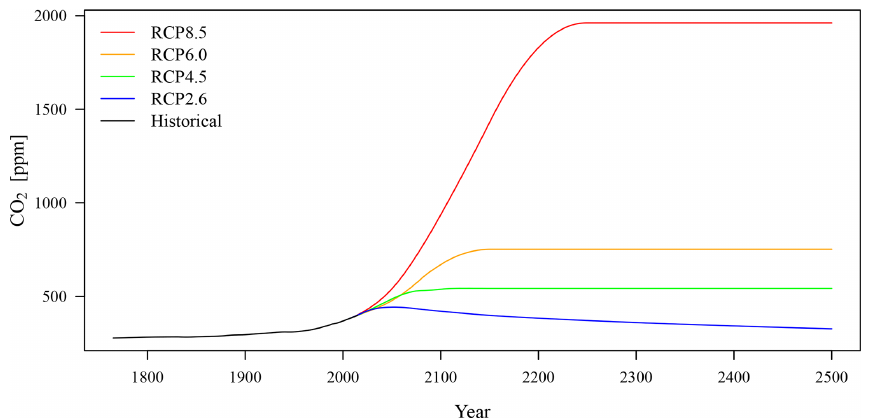
Figure 4. Global atmospheric CO 2 concentrations provided for all sites in the PROFOUND DB. The historical time period extends from 1765 to 2015 and the scenarios from 2005 to 2500 for each